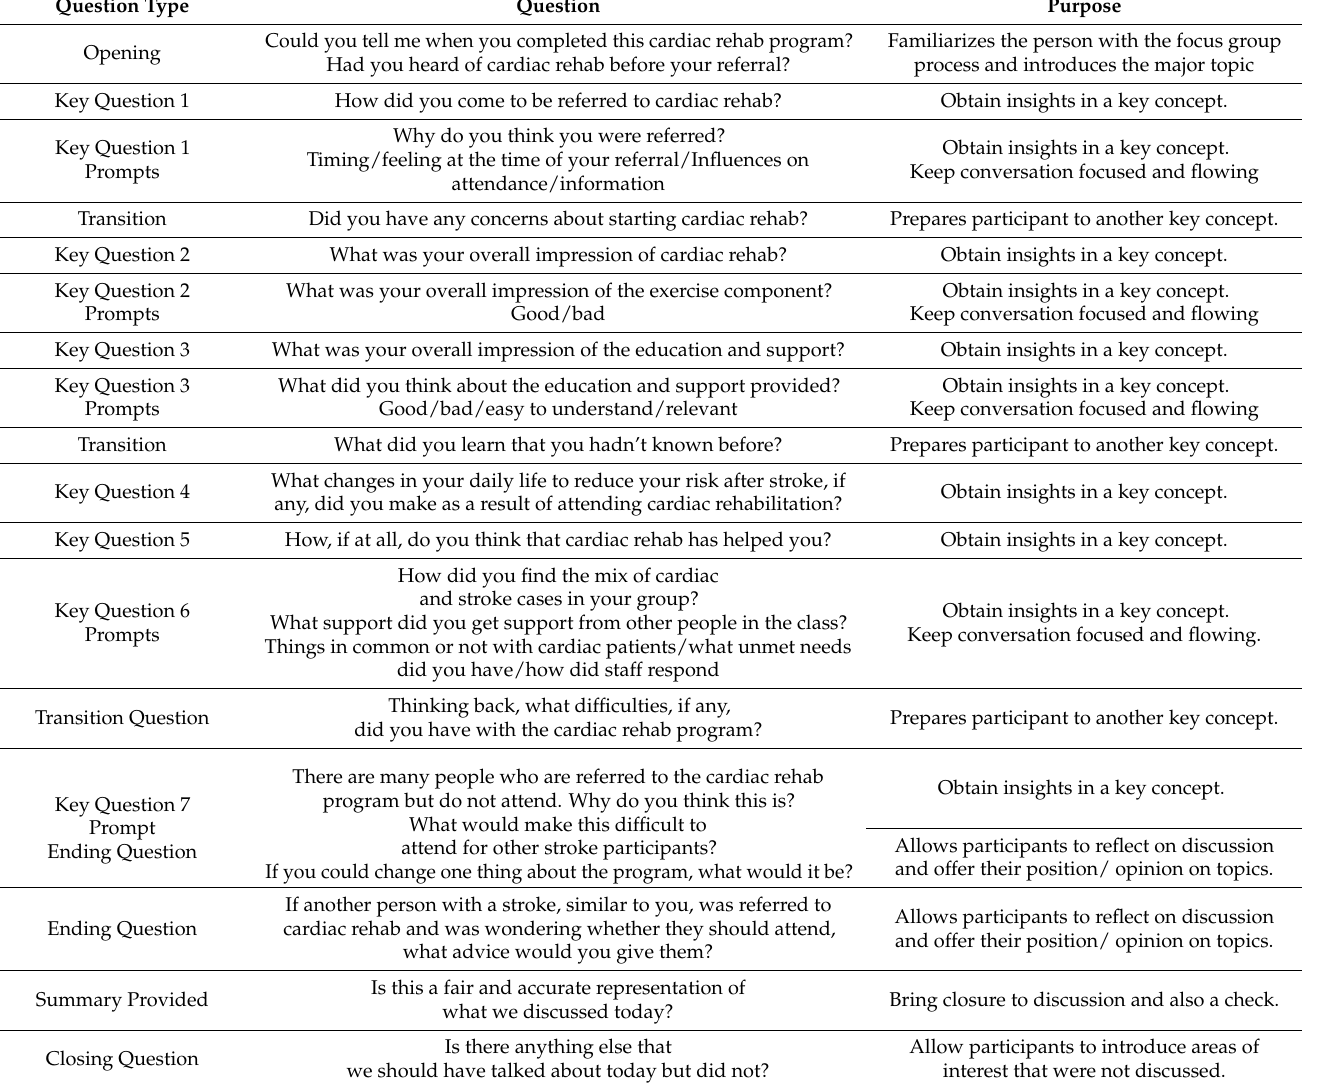
Table 1. Semi-structured focus group question